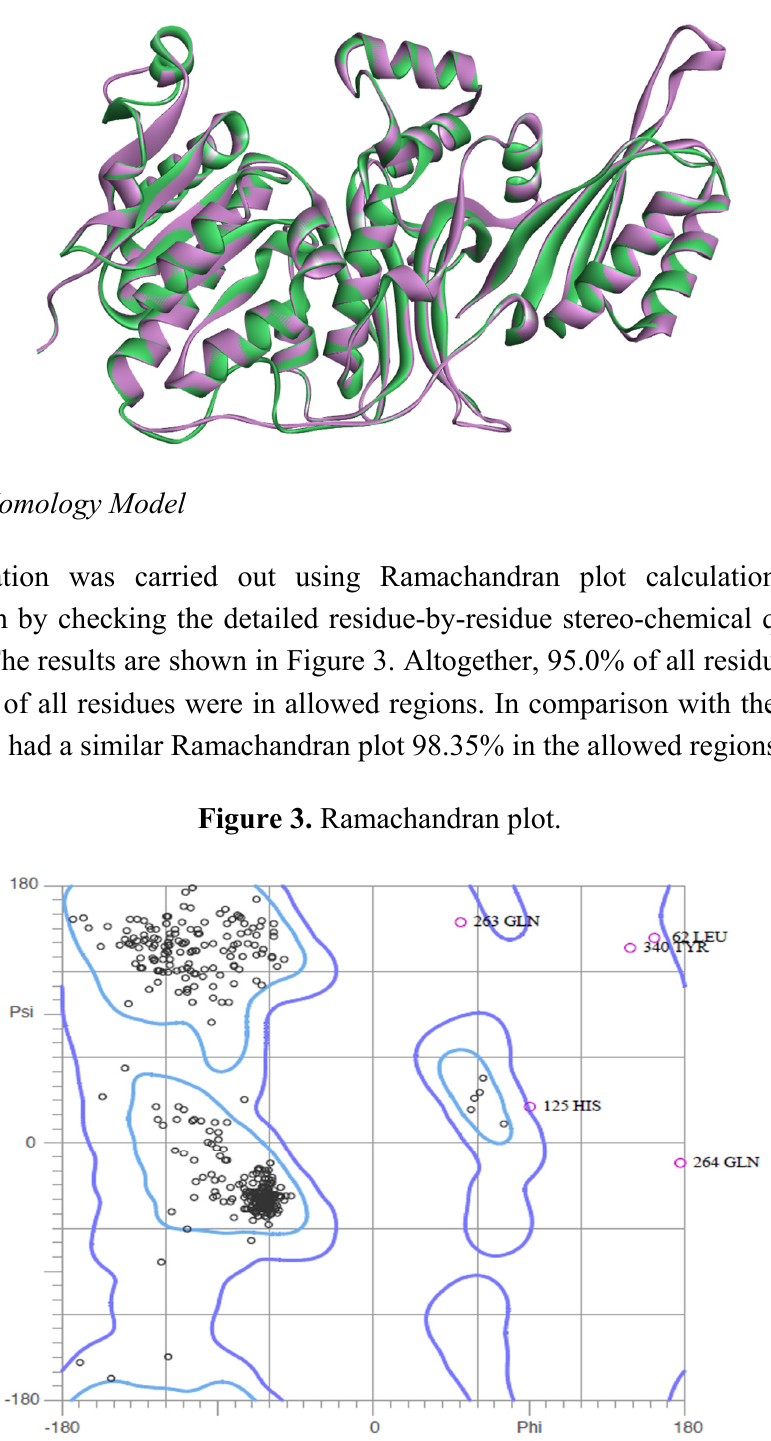
Figure 2. The superposition of the average structure of the HSD (pink) with the initial model (green).